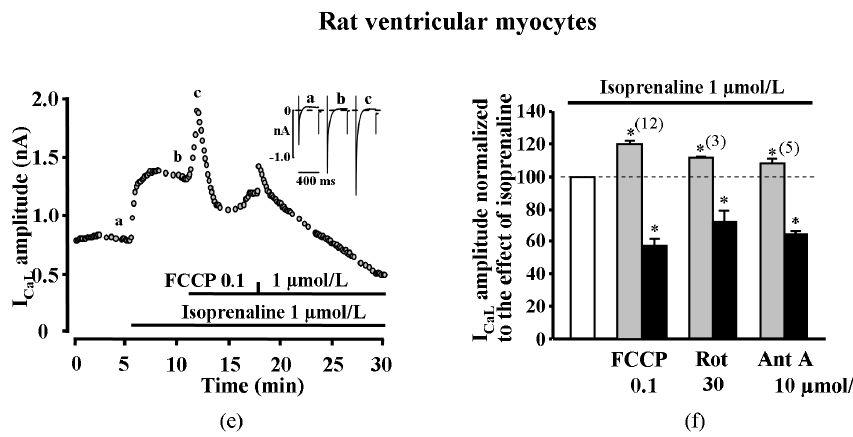
Figure 1. Effect of metabolic inhibition on isoprenaline stimulated I CaL in human and rat cardiomyocytes. ( a ) Effect of FCCP on isoprenaline (ISO)-stimulated I CaL in human atrial cell. Traces of I CaL shown in the panel were recorded at the times indicated by the corresponding letters on the main graph. ( b ) Peak amplitude of I CaL during exposure of ISO-stimulated human atrial cells to FCCP. ( c ) Effect of 2,4-Dinitrophenol (DNP) on ISO-stimulated I CaL in human ventricular cell. Traces of I CaL shown in the panel were recorded at the times indicated by the corresponding letters on the main graph. ( d ) Peak amplitude of I CaL during exposure of ISO-stimulated human ventricular cells to DNP and FCCP. ( e ) Effect of FCCP on ISO-stimulated I CaL in rat ventricular cells. Traces of I CaL shown in the panel were recorded at the times indicated by the corresponding letters on the main graph. ( f ) Peak amplitude of ISO-stimulated I CaL during exposure of rat ventricular cells to various inhibitors of oxidative phosphorylation. White bars in panels ( b ), ( d ) and ( f ) represent 100% of ISO stimulation, grey bars represent transient stimulation of I CaL and black bars represent suppression of I CaL during metabolic inhibition. Values are presented as means ± SEM for the number of cells indicated in parentheses. * p < 0.05 versus ISO alone. DNP—2,4-Dinitrophenol, Rot—rotenone, Ant A—antimycin A.